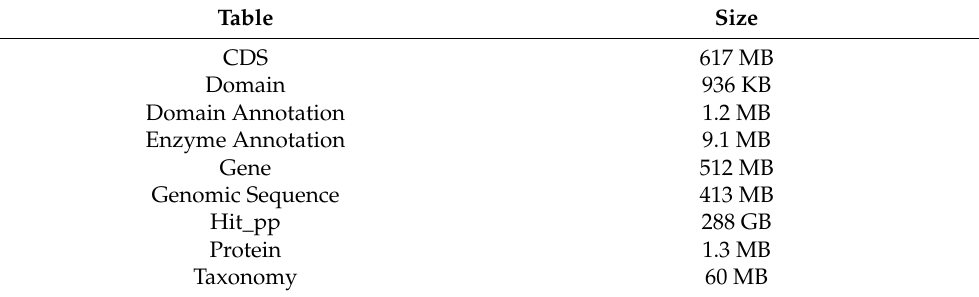
Table 1. PWD relations.